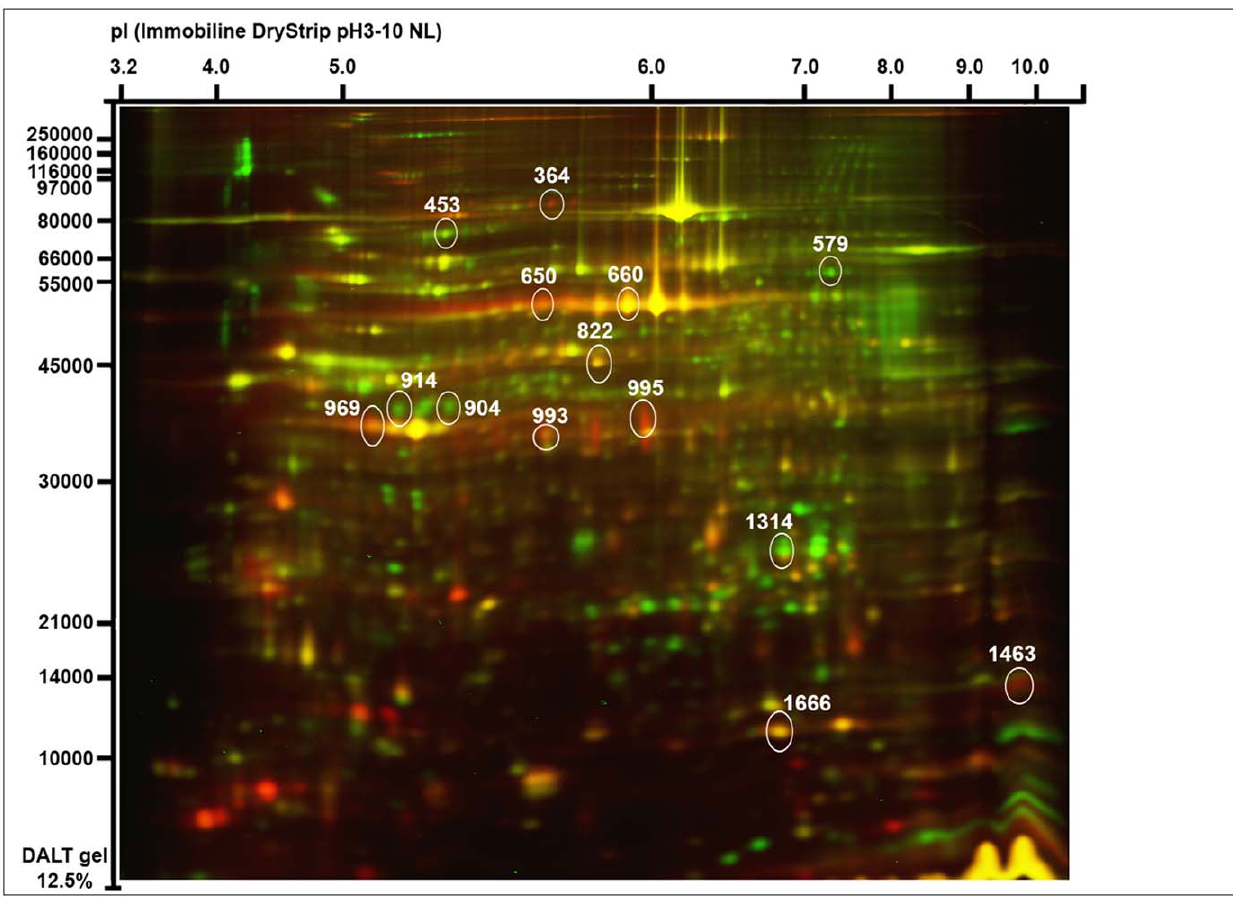
Figure 3. Representative image of the separation of P.volucre proteins on a 2D-DIGE gel. On this merged image, the non diapausing group was labeled with Cy3 (green) and diapausing group was labeled with Cy5 (red). Identified proteins showing differential expression level are annotated on the gel with their respective spot number; complete properties of identified proteins are given in Table 2 and Table S1.